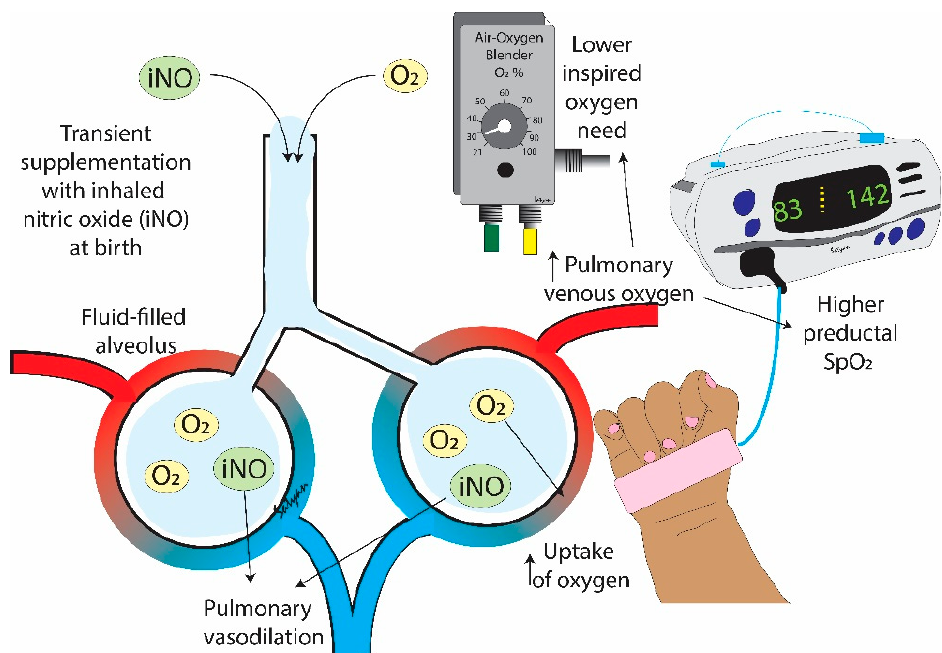
Figure 1. Hypothesis. Newly born, preterm infants have immature lungs filled with liquid. Administration of low concentrations of inspired oxygen alone may not be adequate to achieve target oxygen saturation (SpO 2 ). Transient supplementation with inhaled nitric oxide (iNO) during delivery room resuscitation and stabilization can promote pulmonary vasodilation and enhance gas exchange leading to a lower need for inspired oxygen and higher preductal SpO 2 . Copyright Satyan Lakshminrusimha.